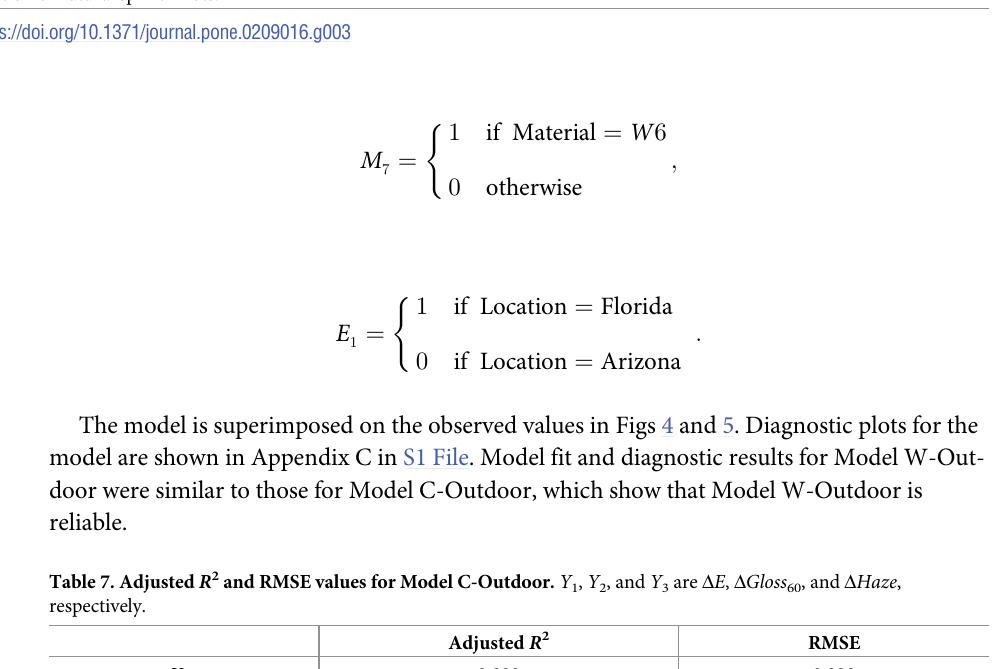
Fig 3. The change in Δ Haze of clear grades of PET under outdoor exposures with the model curves superimposed on the data. Points represent the measured data and solid and dashed lines represent the models. Vertical, dotted lines represent the location of natural spline knots.